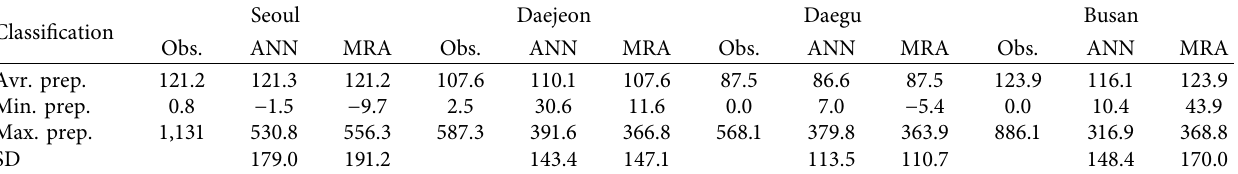
Table 7: Basic statistical analysis between ANN and MRA.